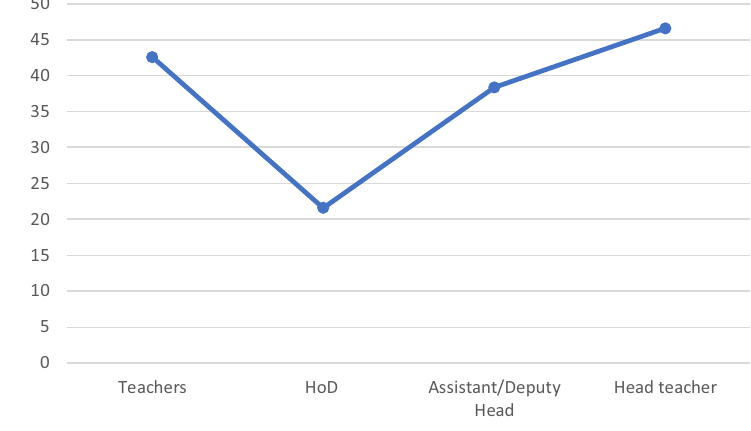
Figure 1. Results of the GERT categorised by functional